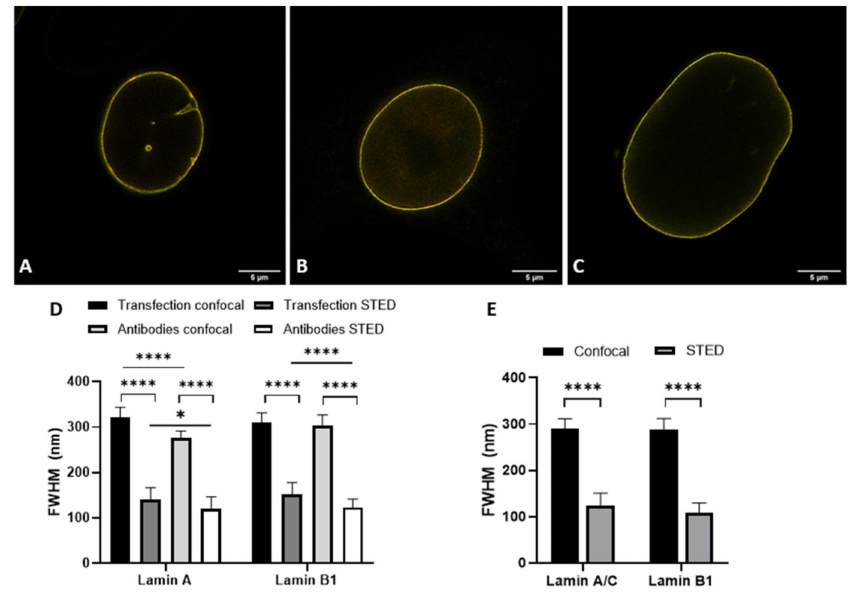
Figure 5. ( A – C ) Merged STED microscopy images of lamin A(/C) (red) and lamin B1 (green). ( A ) 3T3 cells transfected with both lamin-A-YFP and lamin-B1-EGFP. ( B ) 3T3 cells stained with antibodies against lamin A and lamin B1. ( C ) nHDF stained with antibodies against lamin A/C and lamin B1. Scale bars: 5 µ m. ( D , E ) Average FWHM (nm) of confocal and STED microscopy images of co- transfected 3T3 cells and 3T3 cells co-stained with antibodies ( D ), and nHDF stained with antibodies ( E ). Bars, mean ± SD. * p ≤ 0.05; **** p ≤